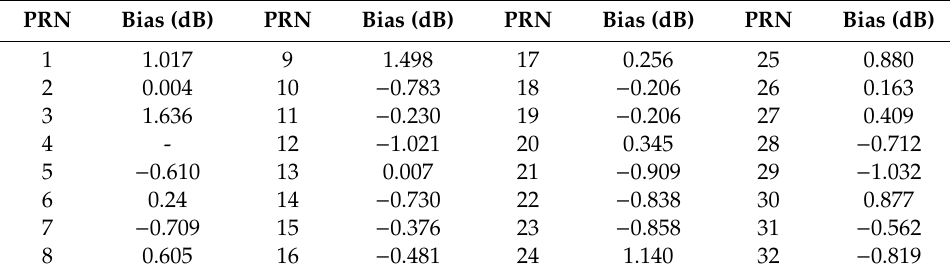
Table 3. Empirical biases in SNR c dB according to pseudorandom noise